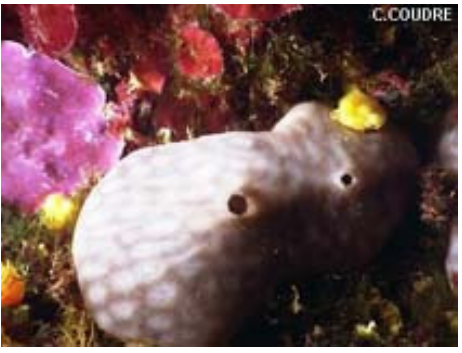
Figure 2. A specimen of Chondrosia reniformis demosponge. © Bernard Picton (CC BY-NC-SA 4.0); http://www.marinespecies.org/.